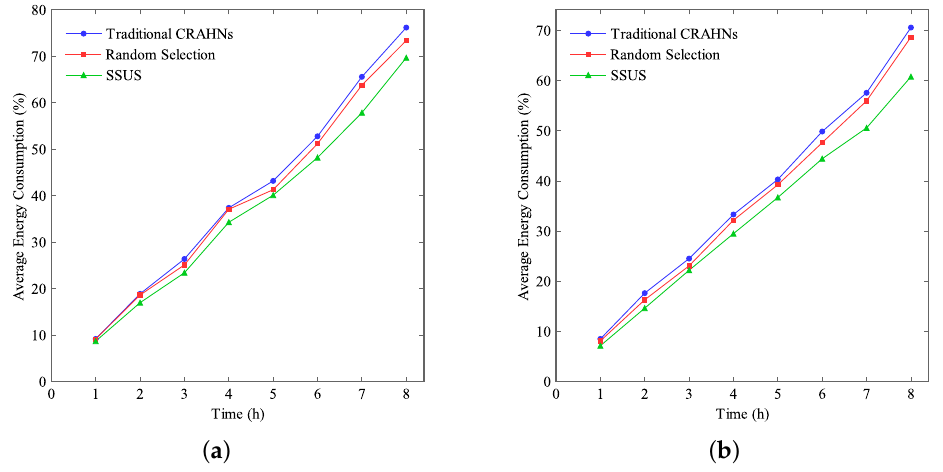
Figure 7. Average energy consumption vs. time. ( a ) Network size is 100 × 100 m 2 , ( b ) Network size is 60 × 60 m 2